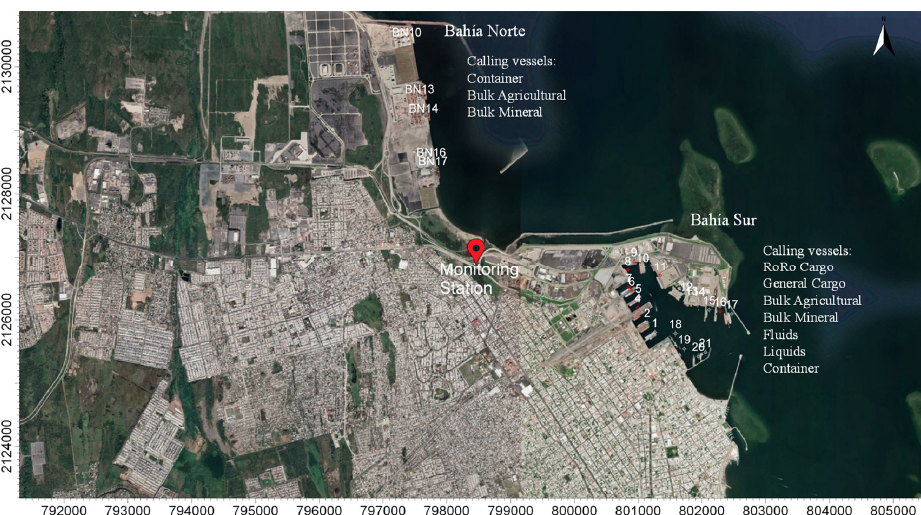
Figure 1. Port of Veracruz. Terrain design from WebGIS CALPUFF model. The SO 2 concentration and meteorological parameters were obtained for the period from January 2018 to December 2020, with data every 10 min using an automatic SO 2 sam- pler, the equivalent method, and Vintage Pro equipment for recording surface meteoro- logical data (wind speed and direction, humidity, temperature, solar radiation, pressure). Wind direction and wind speed frequency are shown in Figure 2 from 2018 to 2020 at the AQMS. In summer, the prevailing winds are from the northeast (NE) and east (E), with a frequency of 10 to 20%. In autumn and winter, the dominant wind direction is N, with wind speeds from 6 to 22 m/s. Southeast (SE) winds were common in the spring season. Overall, The N and ENE winds were the most frequent from 2018 to 2020. These characterize the sea breeze circulation. E and ESE winds were also common and represent airflow from the location of “Bahía Sur”. NW, NNW, and N winds indicate airflow from the “Bahía Norte”. The remaining wind directions indicate the contribution of SO 2 from other emission sources close to AQMS.